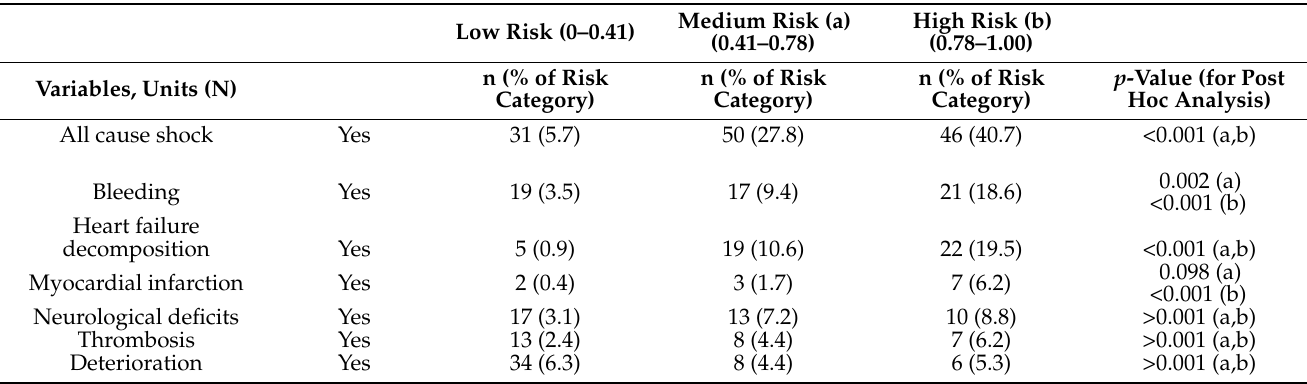
Table 9. Clinical non-fatal events and hospitalization outcomes in the GRAM risk strata. Low Risk